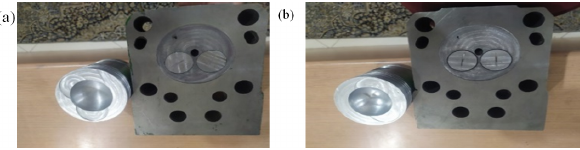
Figure 2: Diesel engine spare parts after modeling; (a) 500 µ m surface remove and (b) 1000 µ m surface